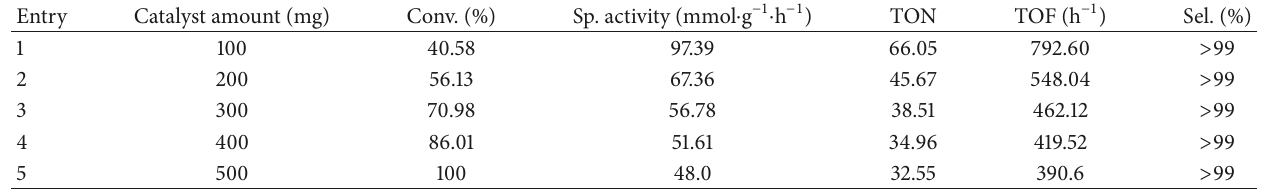
Table 4: The effect of the catalyst 1% ZnO 𝑥 –MnCO 3 amount on the catalytic efficiency. [ a ]